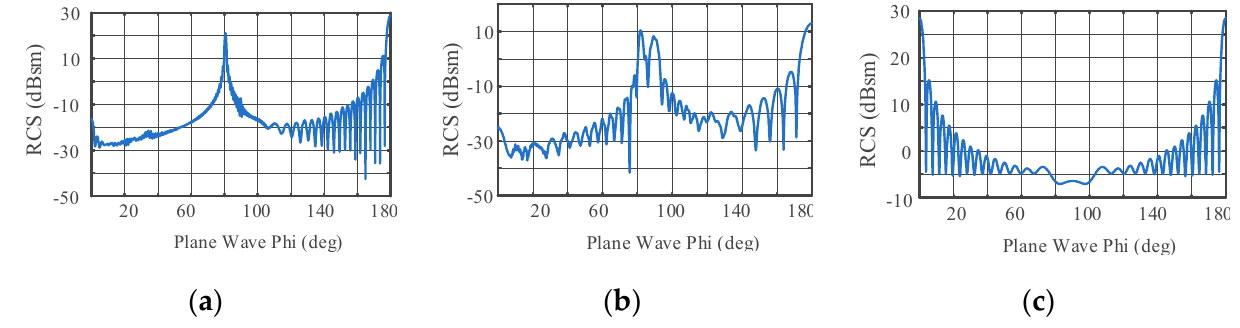
Figure 4. The full attitude-angle static RCS for φ ∈ [0°,180° ]: ( a ) static RCS of cone; ( b ) static RCS of cone plus cylinder; ( c ) static RCS of cylinder.